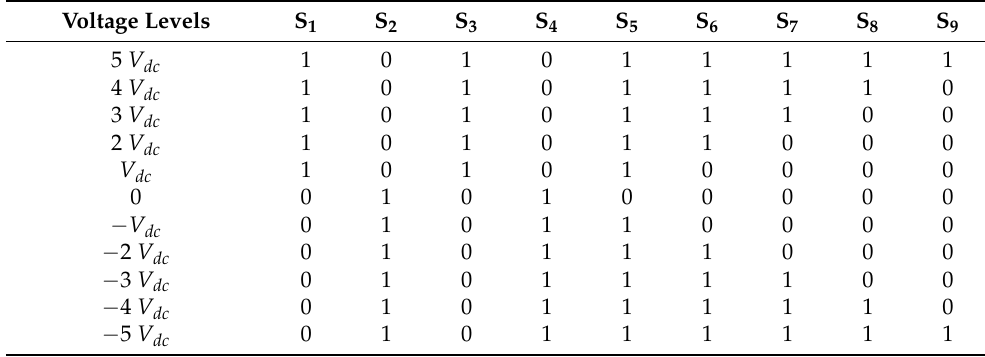
Figure 16. Circuit configuration of proposed multilevel inverter. The switching sequence for the proposed MLI is given in Table 5. Table 5. Switching sequence for proposed MLI.